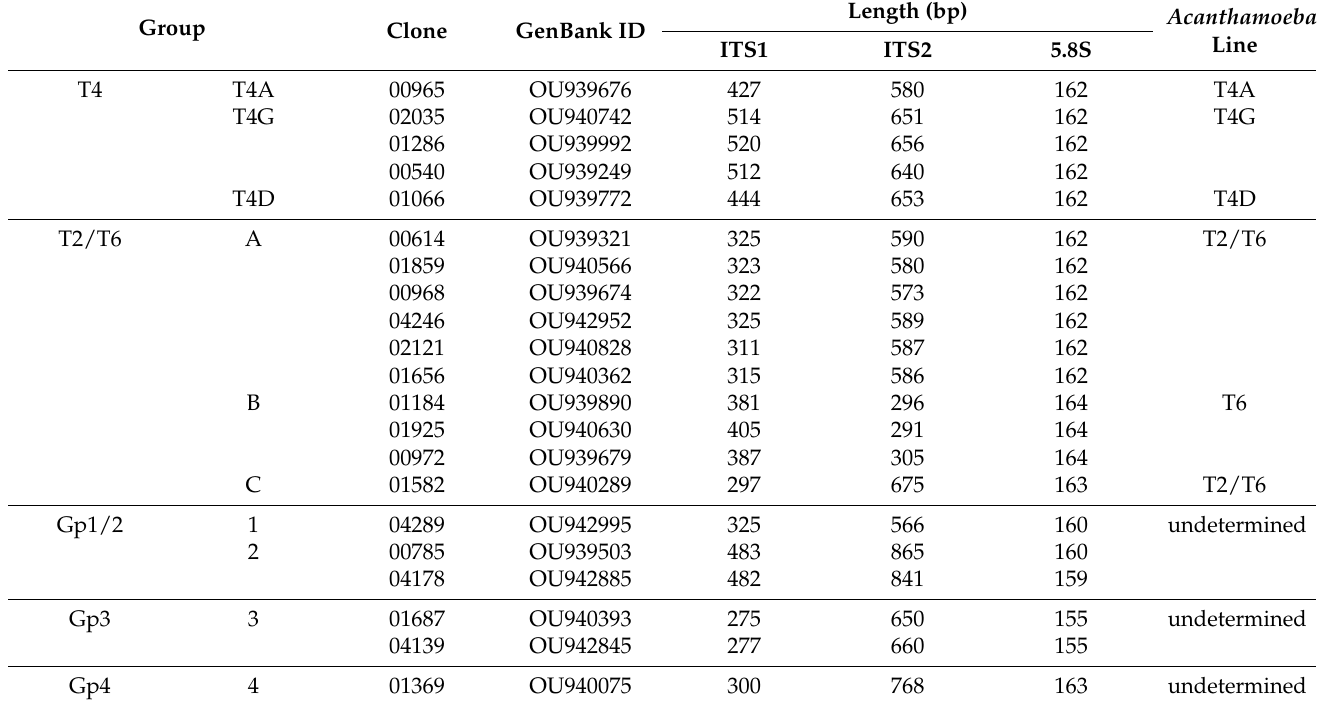
Table 6. ITS lengths of the uncultured Acanthamoeba